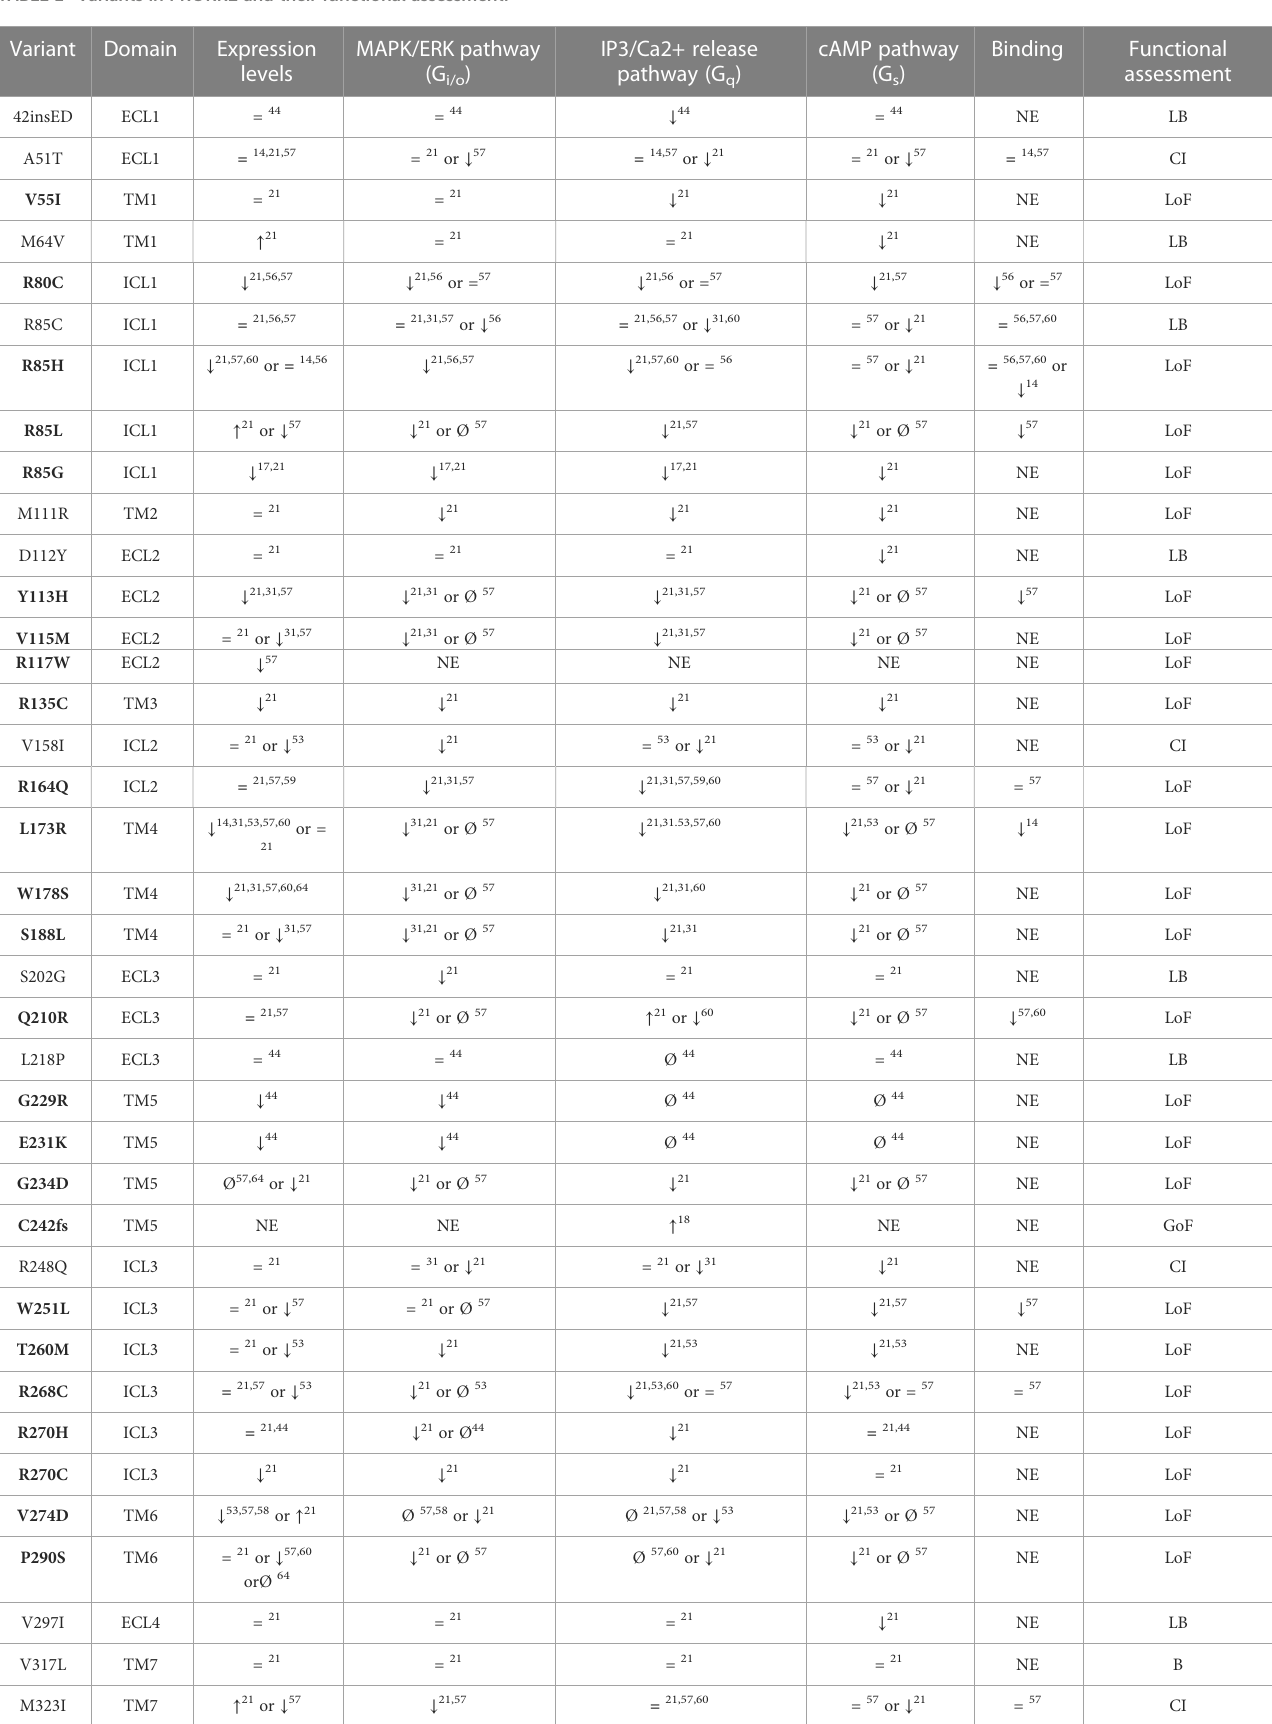
TABLE 1 Variants in PROKR2 and their functional